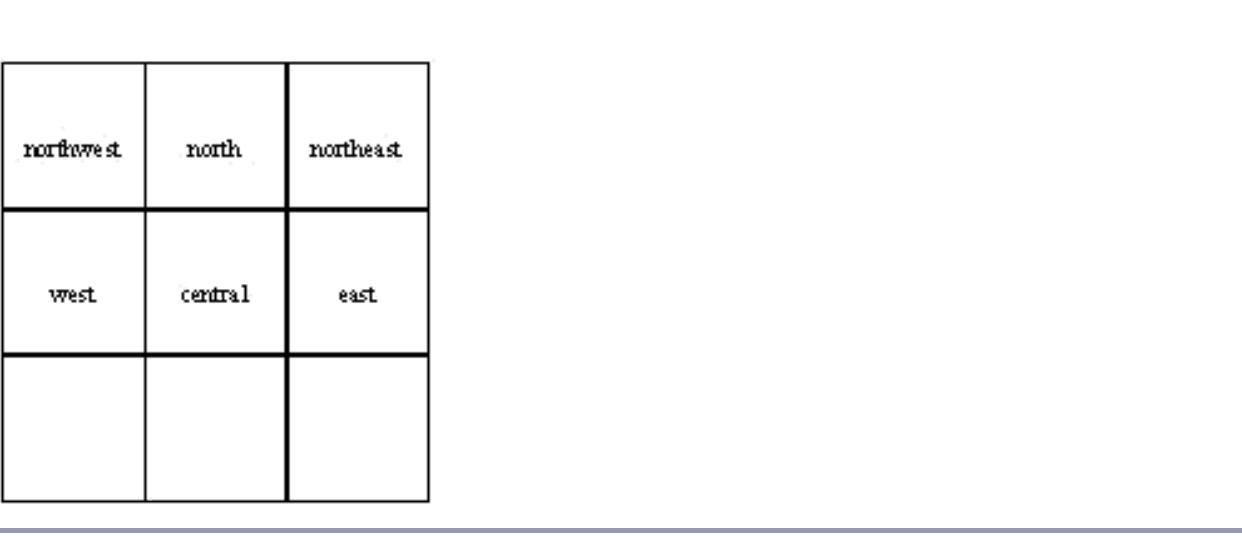
Fig. 4 . An example of a type 1 crack. Shaded cells indicate the linear landscape feature. The arrow shows the crack though which organisms could diagonally sidestep across the